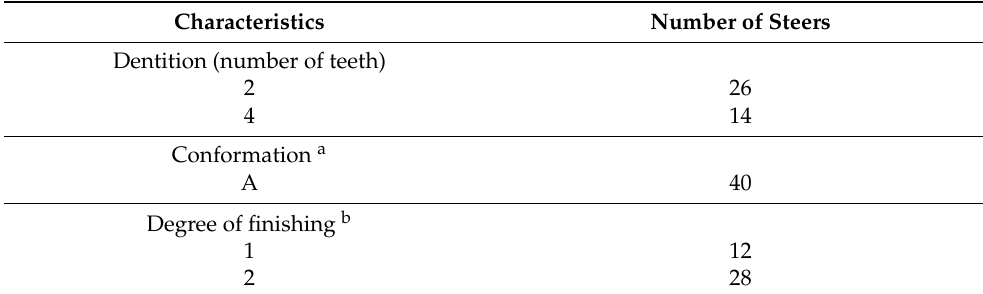
Table 1. Carcass characteristics of the steers (N = 40).